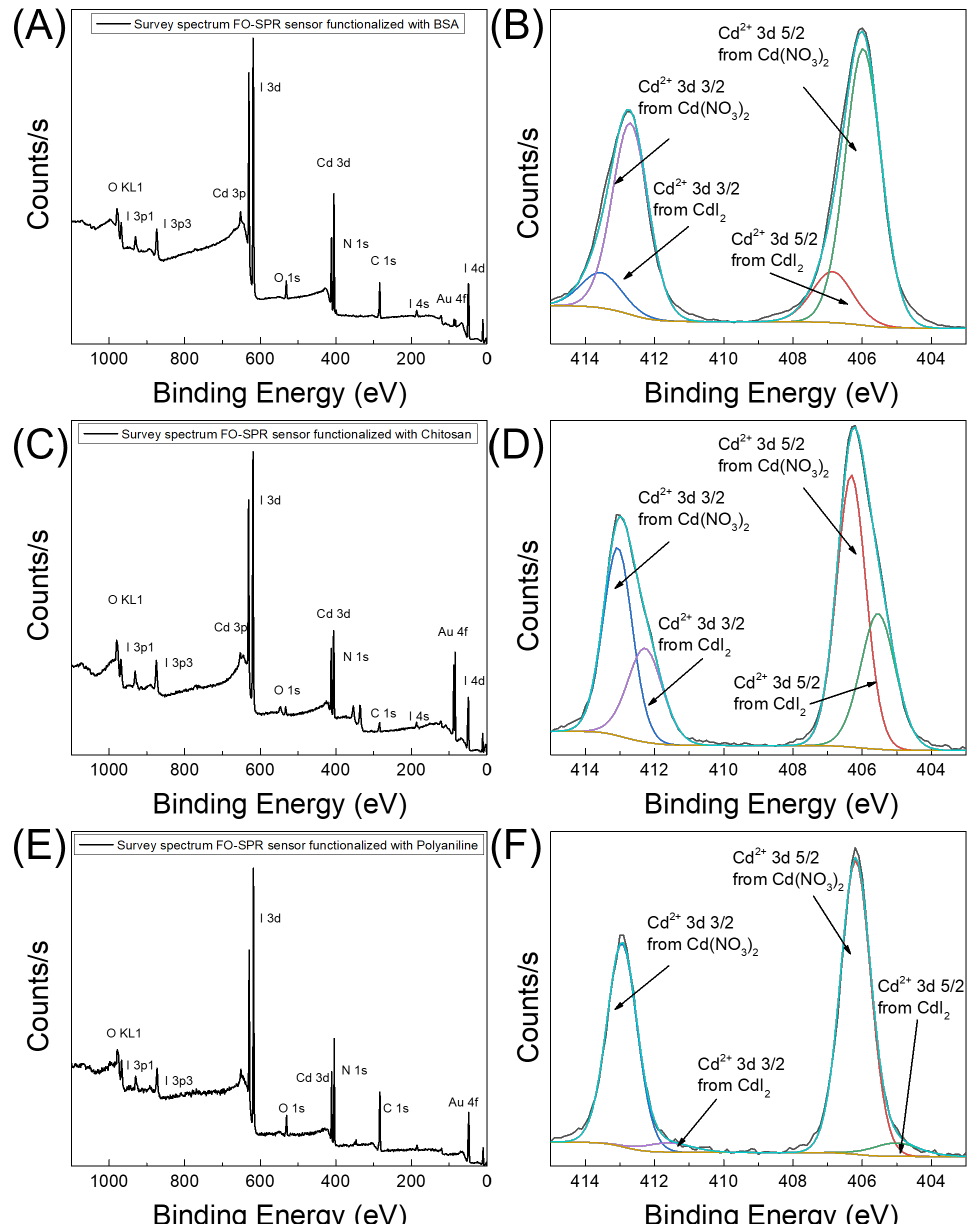
Figure 4. XPS spectra of the FO-SPR sensors’ surfaces. Wide scan of ( A ) BSA/Au, ( C ) chitosan/Au, and ( E ) PANI/Au-coated FO-SPR sensors after 1 µ M Cd 2 + detection, respectively; ( B , D , F ) Corresponding core-level spectra of the Cd 2 + immobilized on the functionalized Au-coated FO-SPR